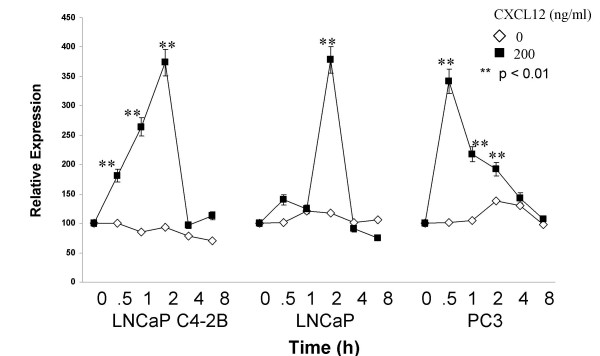
Time course of CD164 mRNA expression by CaPs. QRT-PCR was used to detect changes in CD164 expression by CaP cells following CXCL12 stimulation over time for LNCaP, LNCaP C4-2B, and PC3 cells. The data show that LNCaP and LNCaP C4-2B respond to high concentrations of CXCL12 by increasing CD164 mRNA expression. PC3 cells increase CD164 expression to moderate concentrations of CXCL12 (20 ng/ml), but at higher CXCL12 doses (200 ng/ml) down regulate expression.